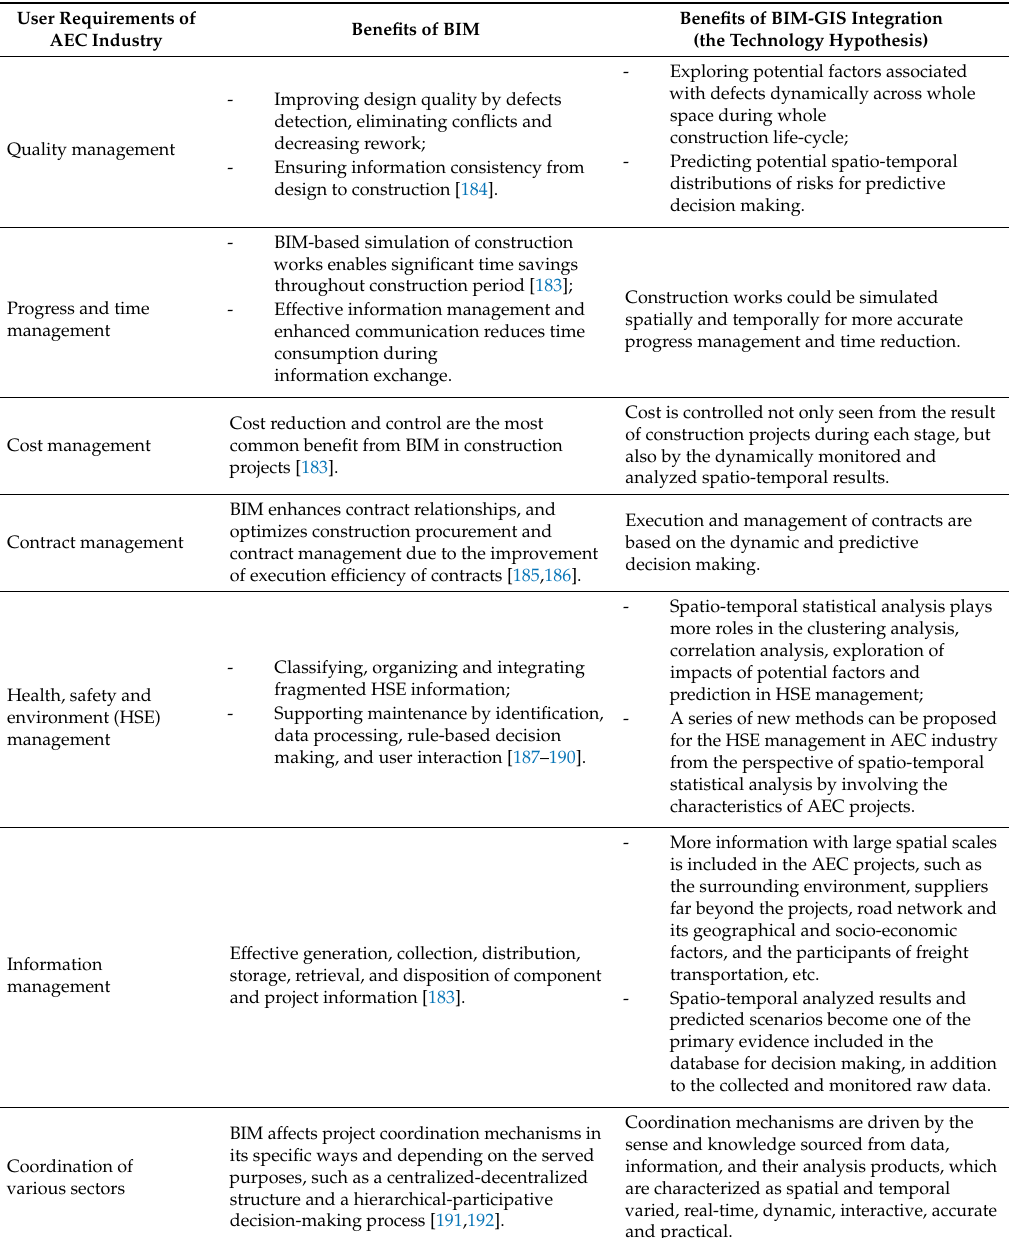
Table 6. Comparison of benefits of BIM and BIM-GIS integration in satisfying the user requirements of AEC